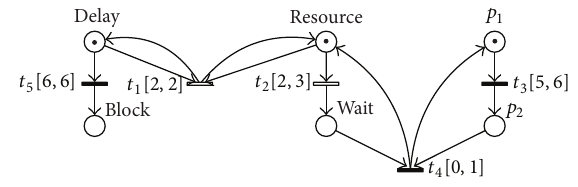
Figure 17: A periodic system with 𝑇 𝑐 = {𝑡 1 ,𝑡 2 }